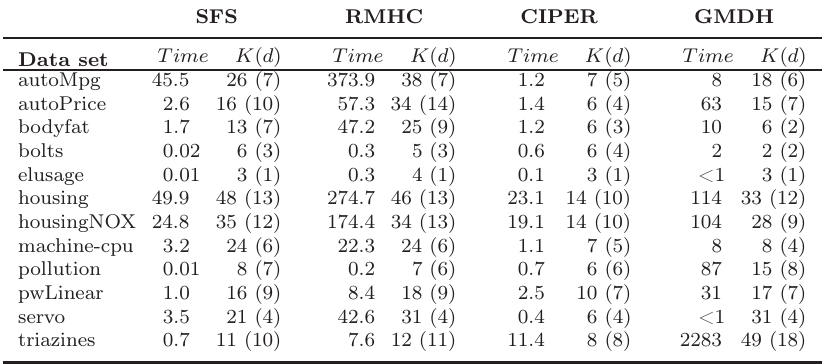
Table 3. Average running time (in s), average number of basis functions ( K ) and average number of included variables (d) of the induced models (GMDH time was measured only to a precision of 1